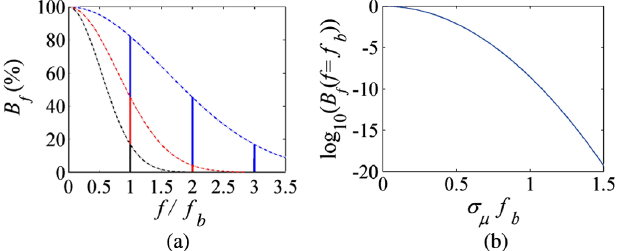
FIG. 1. (a) Bunching factor spectra [ B f ð f Þ , solid line] and Gaussian envelopes [ G ð f Þ , dashed line] of Gaussian electron- pulse trains with rms microbunch lengths of 0 . 1 =f b (blue curve), 0 . 2 =f 0 . 3 =f b (red curve), and b (black curve). (b) Bunching factor B f ¼ f f at b versus normalized rms bunch length Gaussian electron-pulse